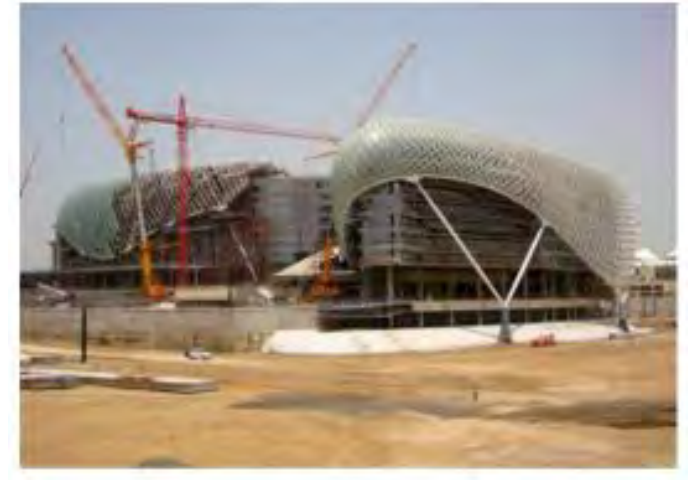
Figure 17. The Yas Viceroy Abu Dhabi Hotel.